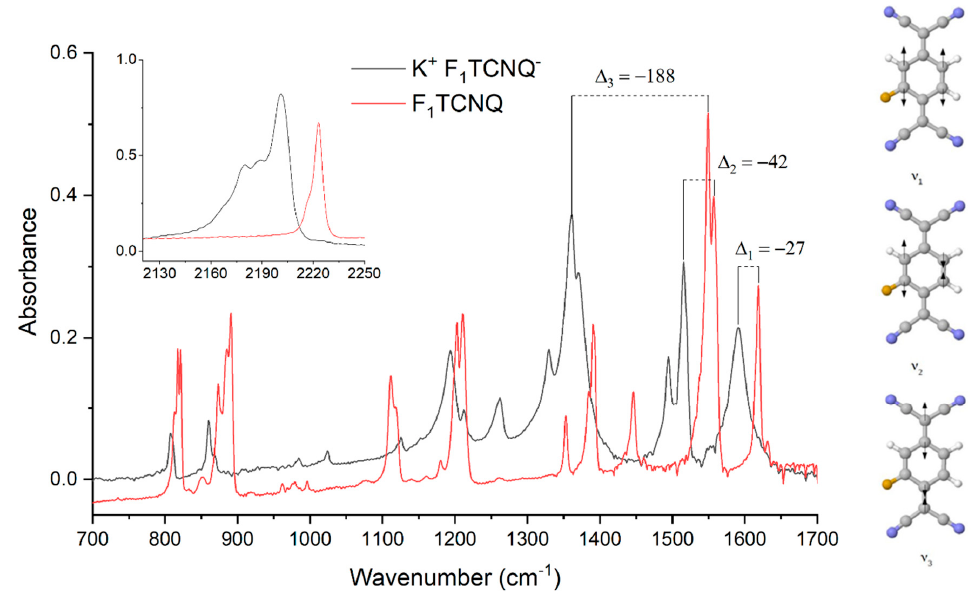
Figure 3. IR absorption spectra of TCNQF 1 and K + TCNQF 1 − powders ( left ) and schematics of the charge sensitive vibrational modes ( right ).